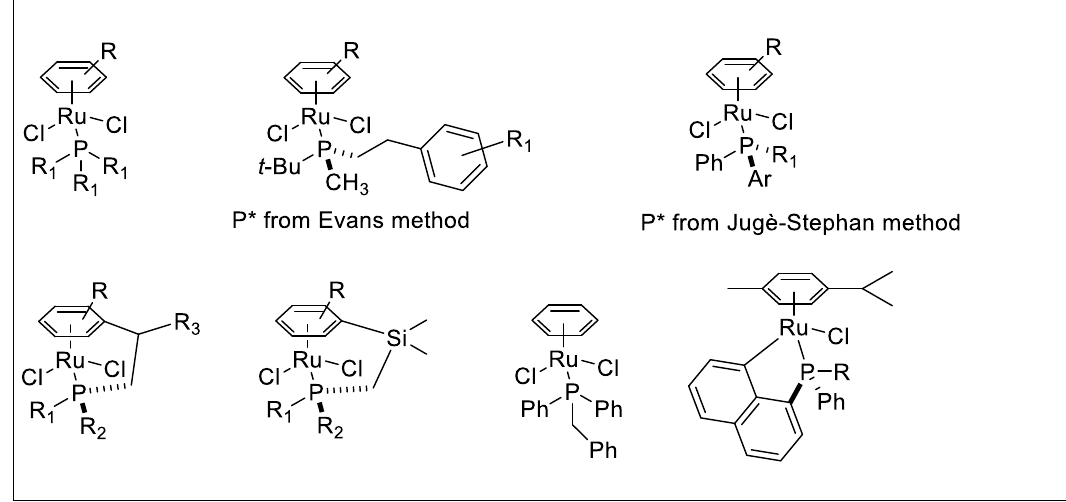
Figure 2. Overview of [RuCl 2 ( η 6 -arene)(P)] catalytic precursors.